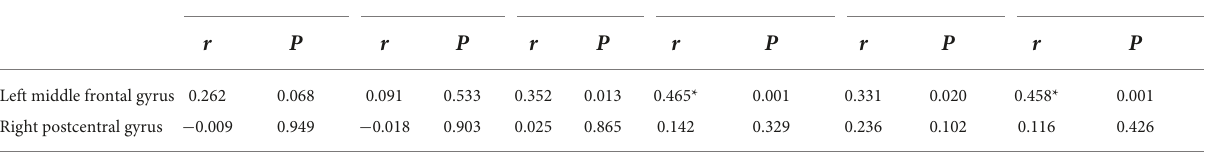
TABLE 6 Partial correlation between CTQ scores and ALFF. Brain